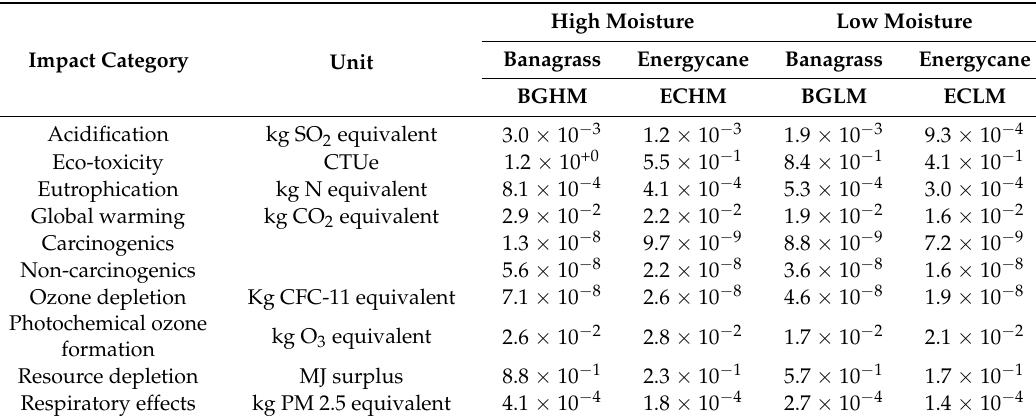
Table 4. Environmental impacts of different